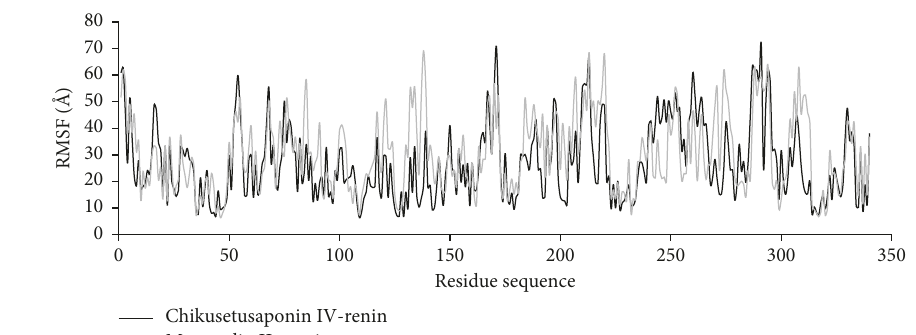
Figure 3: The RMSDs of complexes.